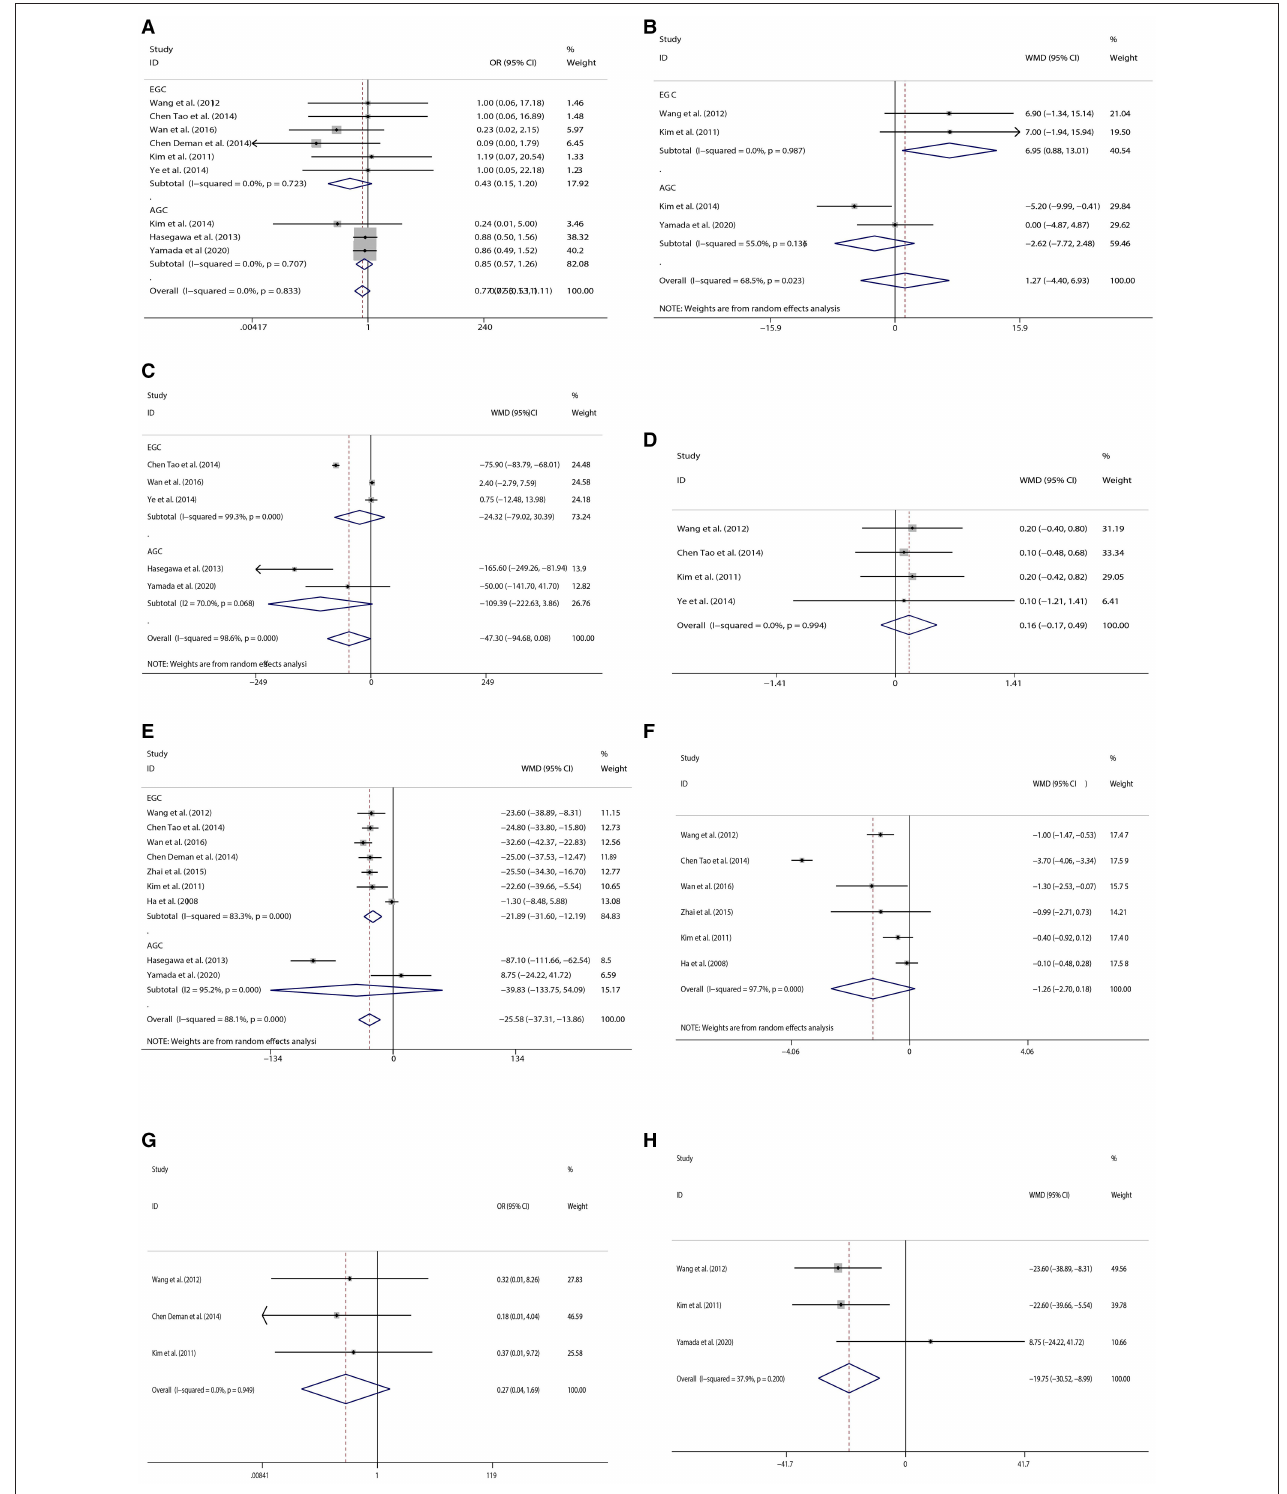
FIGURE 2 | Forest plots[ (A) Complications, (B) The number of retrieved lymph nodes, (C) Intraoperative blood loss, (D) Time to first flatus, (E) Operation time, (F) Postoperative hospital stay, (G) Blood Infusion, (H) Comparison of operation time in open surgery].